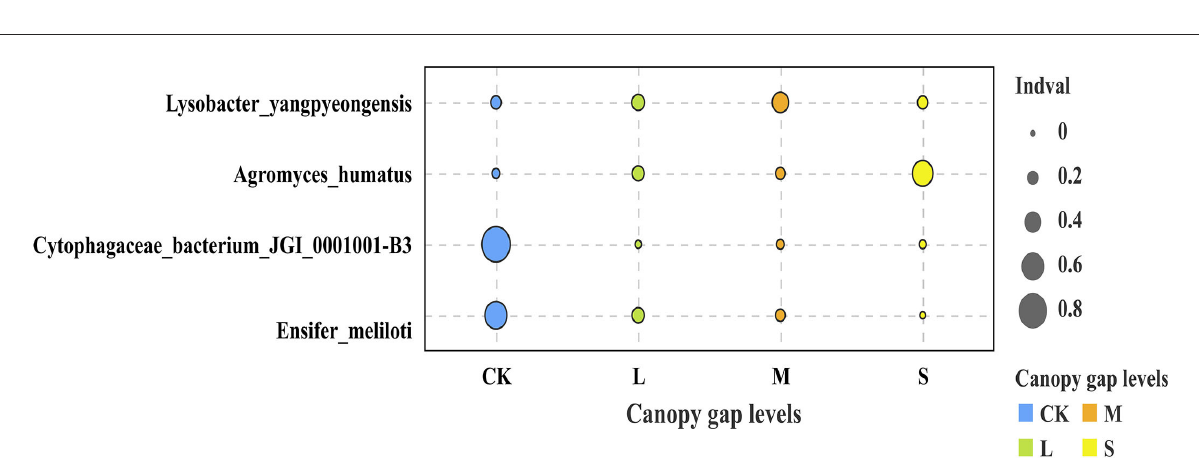
FIGURE4 Soil bacteria community indicator species in the three different forest gaps. Only species with abundance value > 0, total proportion > 0.1%, and p < 0.05 are shown. “S” stands for small gaps; “M” stands for medium gaps; and “L” stands for large gaps.